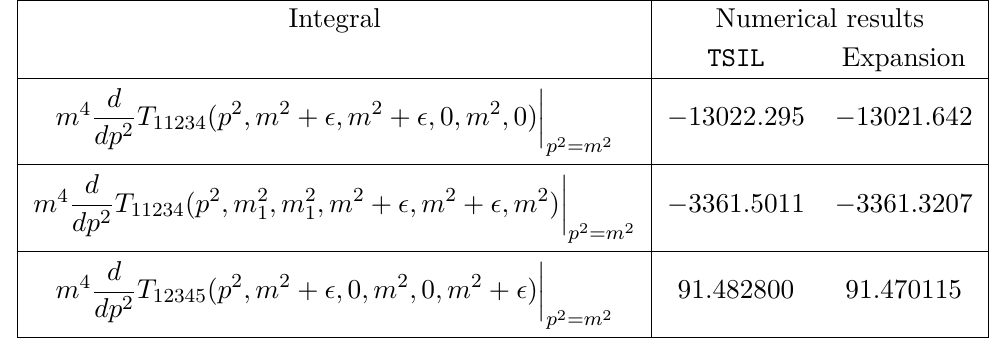
Table 3. Example values of the derivatives of T 11234 and T 12345 , multiplied by m 4 to obtain dimensionless numbers, computed by TSIL and with the approximate expansions of eqs. (B.8) to (B.10). The mass values are chosen to be m = 100 GeV, (cid:15) = 1 GeV 2 , m 1 = 1 GeV, and the numerical derivatives are computed with a step size of δ = 10 − 3 GeV 2